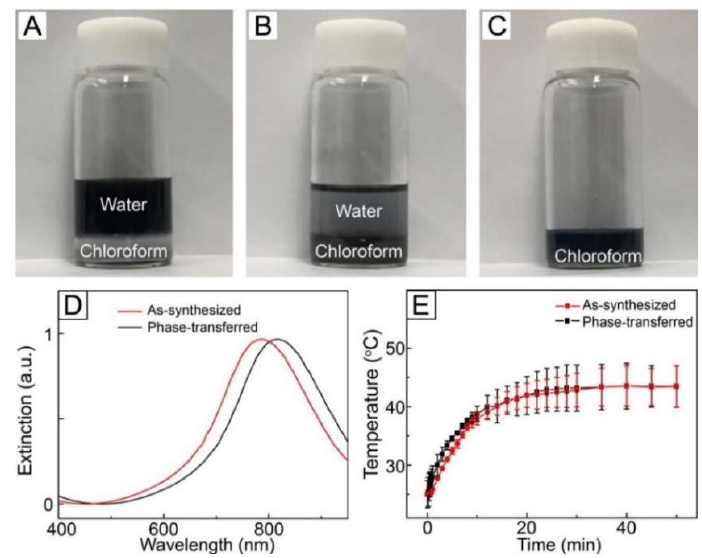
Figure 2. Photographs of AuNC solutions: ( A ) a mixture solution of AuNCs and PEG-thiol in a co-solvent of DI water and chloroform before vigorous agitation, ( B ) a mixture solution of AuNCs and PEG-thiol in a co-solvent of DI water and chloroform after vigorous agitation, and ( C ) a solution of phase-transferred AuNCs in chloroform. ( D ) UV–VIS–NIR extinction spectra for as-synthesized AuNCs in DI water and phase-transferred AuNCs in chloroform. ( E ) Time-dependent change in temperature for the as-synthesized AuNC solution in DI water and the phase-transferred AuNC solution in chloroform under NIR light irradiation (1 W/cm 2 , 808 nm).